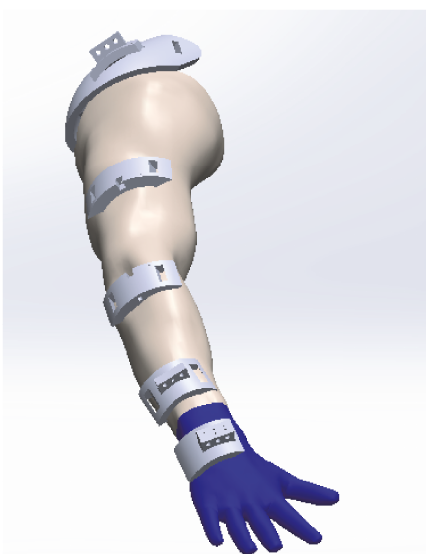
Figure 7: Design of a wearable exoskeleton for elbow medical rehabilitation.